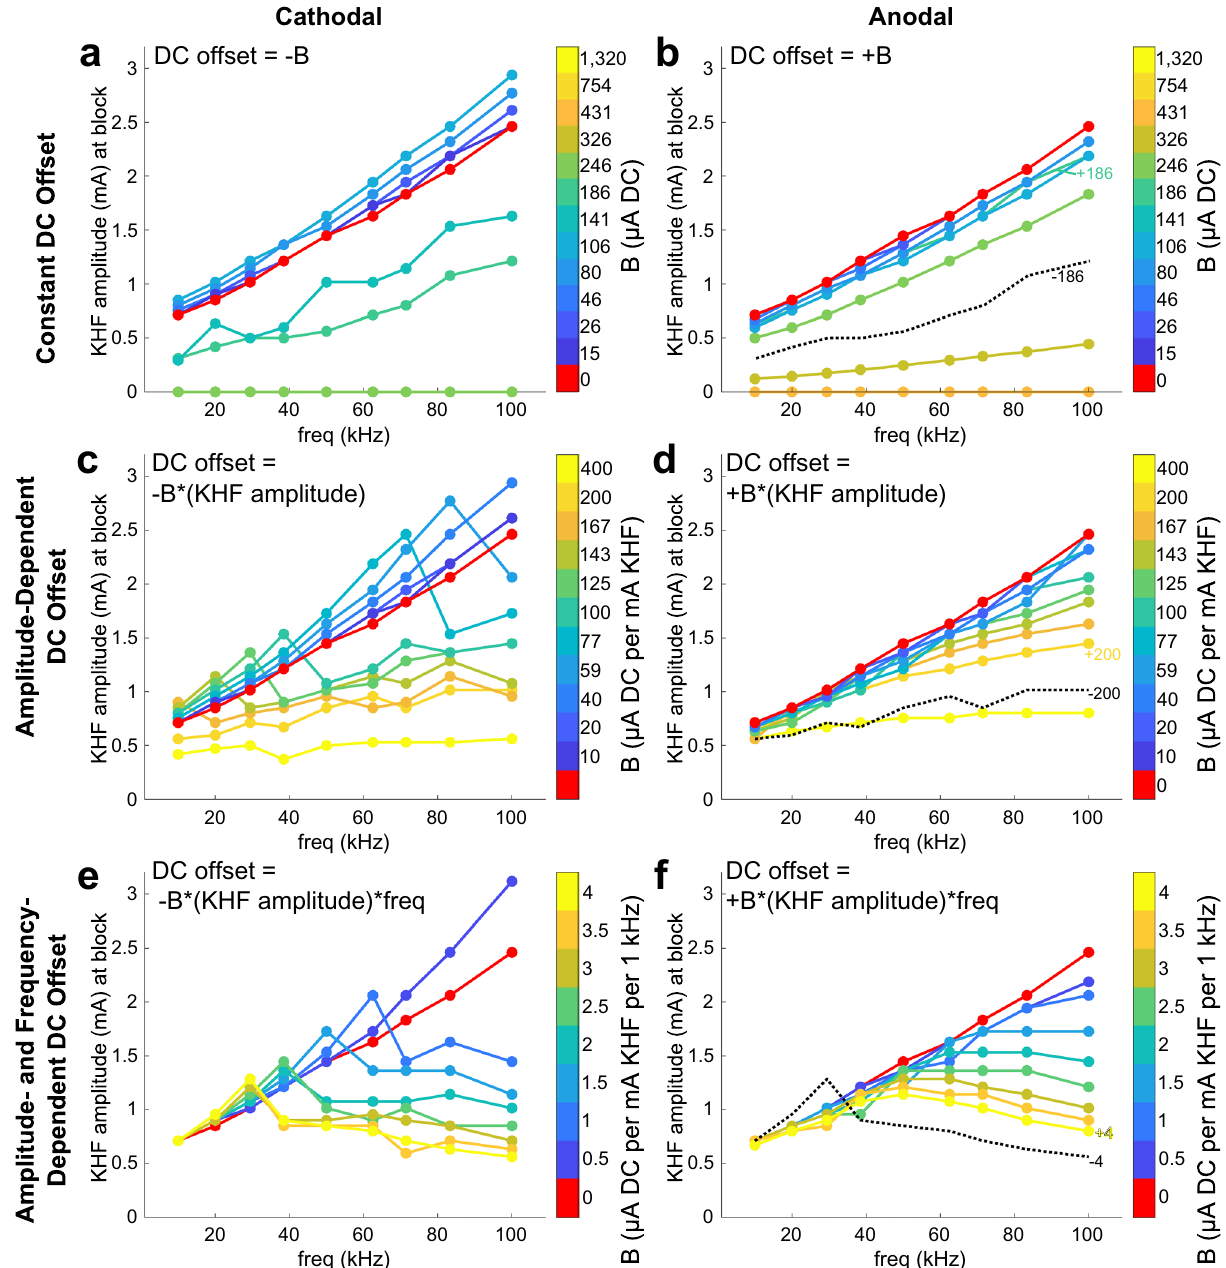
Figure 3. Frequency effects on block thresholds in computational models of symmetric KHF rectangular waves with different types of DC offsets. Polarities apply to the proximal contact of the bipolar cuff (Fig. 2) and the signs of the DC offsets are for the current on the proximal contact. Model axons were myelinated and had a 5.7 μm fiber diameter. KHF amplitude indicates half of the peak-to-peak amplitude of the KHF waveform. ( a , b ) Block thresholds due to constant DC offset for cathodal ( a ) and anodal ( b ) polarities. The data for the four ( a ) and three ( b ) highest levels of DC are overlaid at zero threshold. Thresholds at 1320 μA are not shown for cathodal DC because this amplitude produced only DC excitation. The black dotted line on the anodal DC plot shows the − 186 μA data from the cathodal DC plot. ( c , d ) Block thresholds of KHF waveforms with cathodal ( c ) and anodal ( d ) DC offsets that scale with KHF amplitude. The black dotted line on the anodal DC plot shows the − 200 μA per mA KHF data from the cathodal DC plot. ( e , f ) Block thresholds for KHF waveforms with cathodal ( e ) and anodal ( f ) DC offsets that scale with KHF amplitude and frequency. The black dotted line on the anodal DC plot shows the − 4 μA per mA KHF per 1 kHz data from the cathodal DC